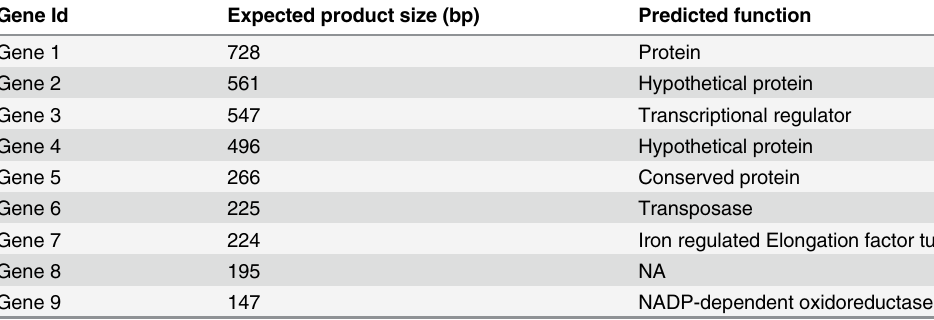
Table 3. Summary of gene clusters absent from Mtb ATCC H37Ra and Mtb ATCC